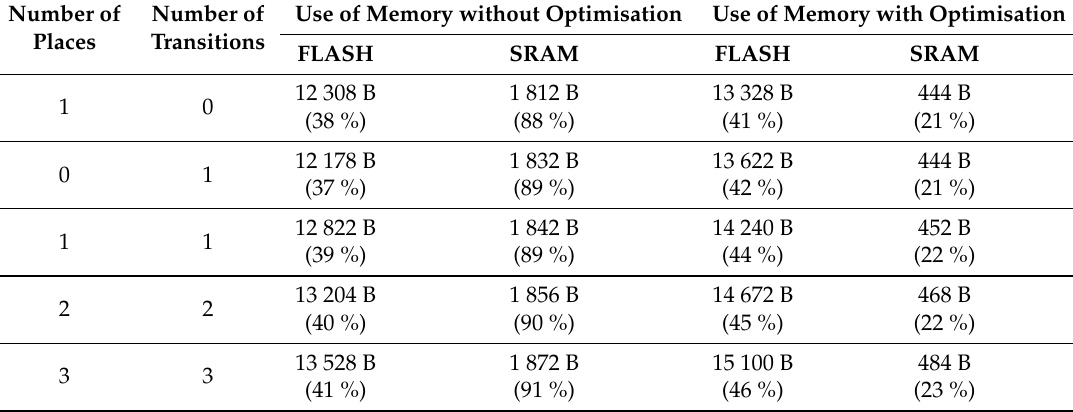
Table 2. The use of memory without optimisation and with